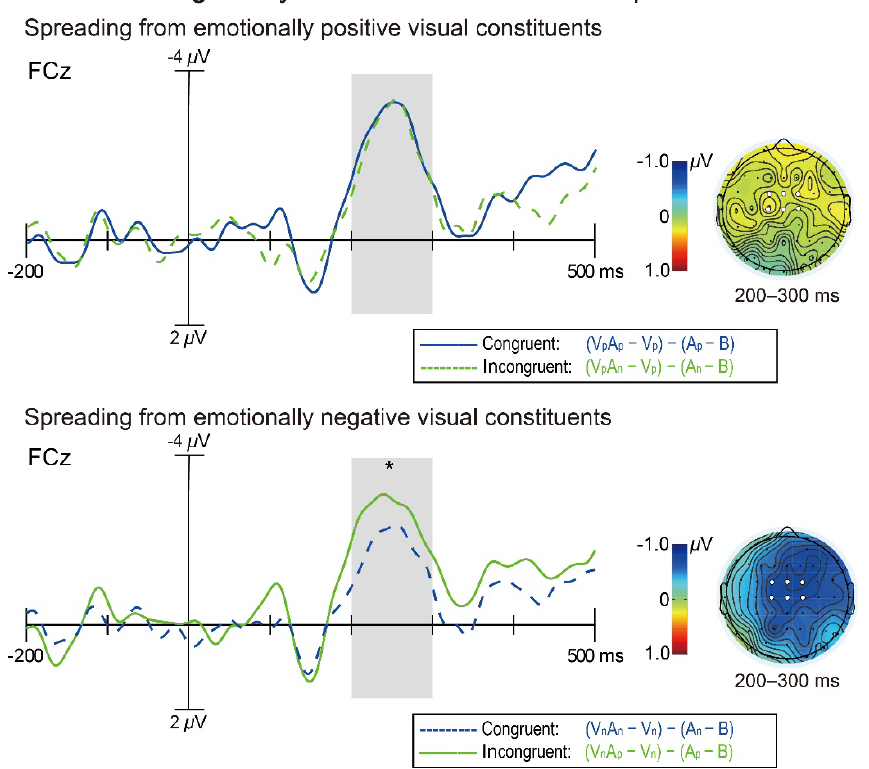
Figure 3. The magnitude of the stimulus-driven auditory Nd wave (measured as the extracted-auditory minus auditory-only ERP difference) in response to emotionally congruent (blue traces) and incongruent (green traces) audiovisual stimuli, plotted separately for audiovisual stimuli with emotionally positive (upper half) and negative (lower half) visual constituents. The shaded areas on waveforms depict the time window of 200–300 ms within which the Nd magnitudes were further contrasted. Scalp topographies are shown for incongruent minus congruent Nd magnitude differences during the time window of 200–300 ms. The Nd magnitude was significantly larger for emotionally incongruent than congruent audiovisual stimuli only when their visual constituents’ emotional valence was negative. *: p < 0.05 for the incongruent vs. congruent contrast.